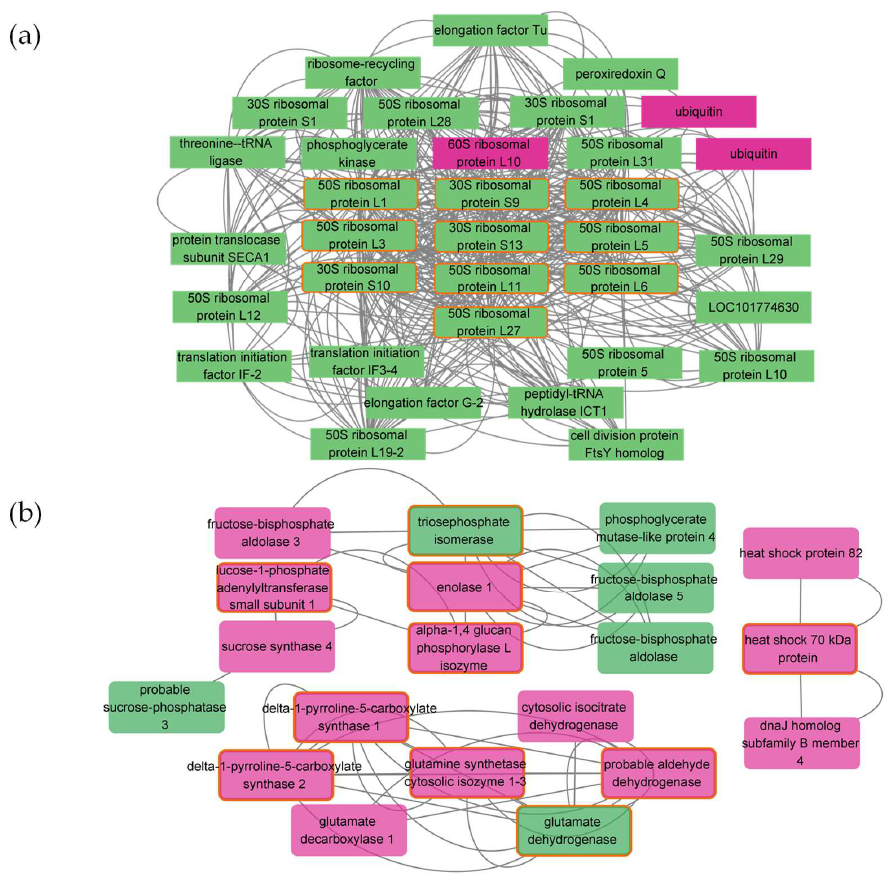
Figure 5. Protein–protein interaction network of Hub genes in salt-sensitive ( a ) and salt-tolerant ( b ) accessions. The green and red colors represent down- and up-regulated genes, respectively. All interactions had the highest confidence (0.900) to minimize false functional links. Table 2. Hub gene information by maximal clique centrality method.